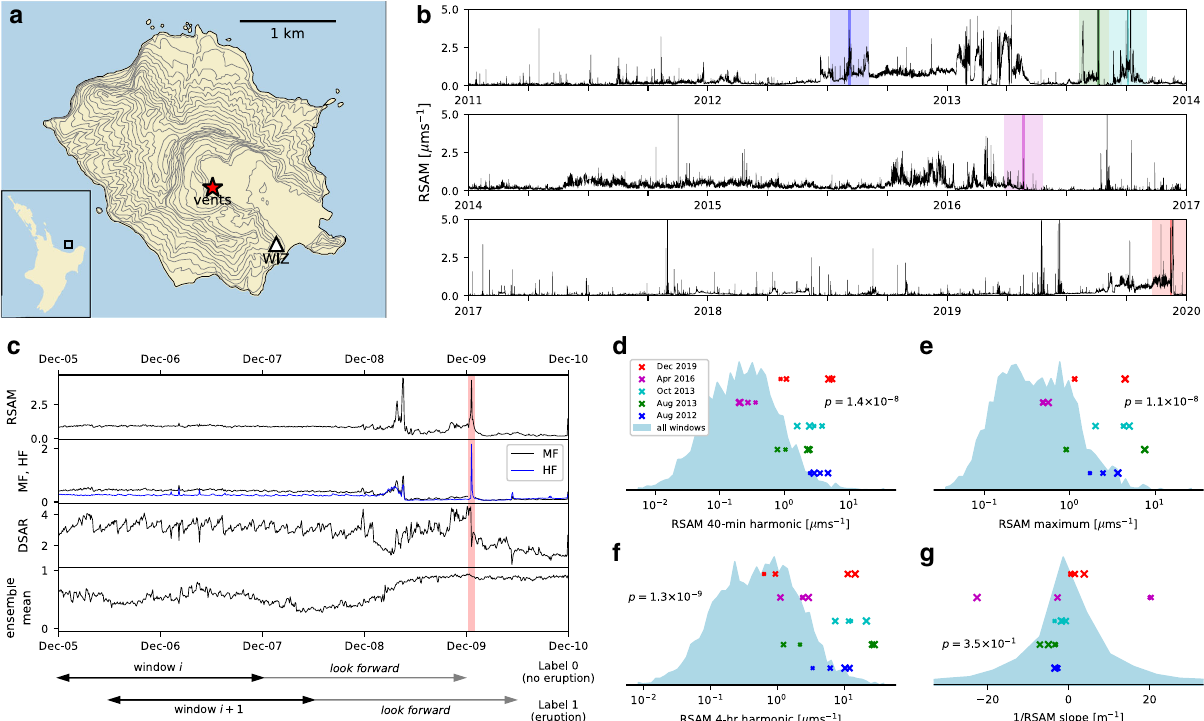
Fig. 1 Whakaari tremor data and features. a Location of vents and seismic station at Whakaari volcano. b RSAM (Real-time Seismic Amplitude Measurement) tremor signal over the 9-year study period, with fi ve eruptive periods indicated by darkened colored lines. The wide-shaded bar either side of each eruption demarcates the testing interval during cross-validation. c Tremor time series (RSAM, MF, HF, DSAR) in the 4 days preceding the December 2019 eruption, indicated by the vertical red bar (UTC time). The relative positions of two adjacent windows (black arrows at bottom of c ) and their associated look-forward periods are indicated below. The eruption falls outside the look-forward period (gray arrow) of window i , but inside the look- forward of i + 1, and are thus labeled 0 and 1, respectively. The ensemble mean of an eruption forecast model that accepts the windowed tremor data is given in the bottom frame of ( c ). d – g Frequency distribution of exemplary feature values, with values prior to the fi ve eruptions (colored markers, corresponding to colored lines in ( b ) explicitly plotted. d – f show statistically signi fi cant features for eruption forecasting. Larger markers denote a window nearer to the eruption. Mann – Whitney U p values are quoted and indicate feature signi fi